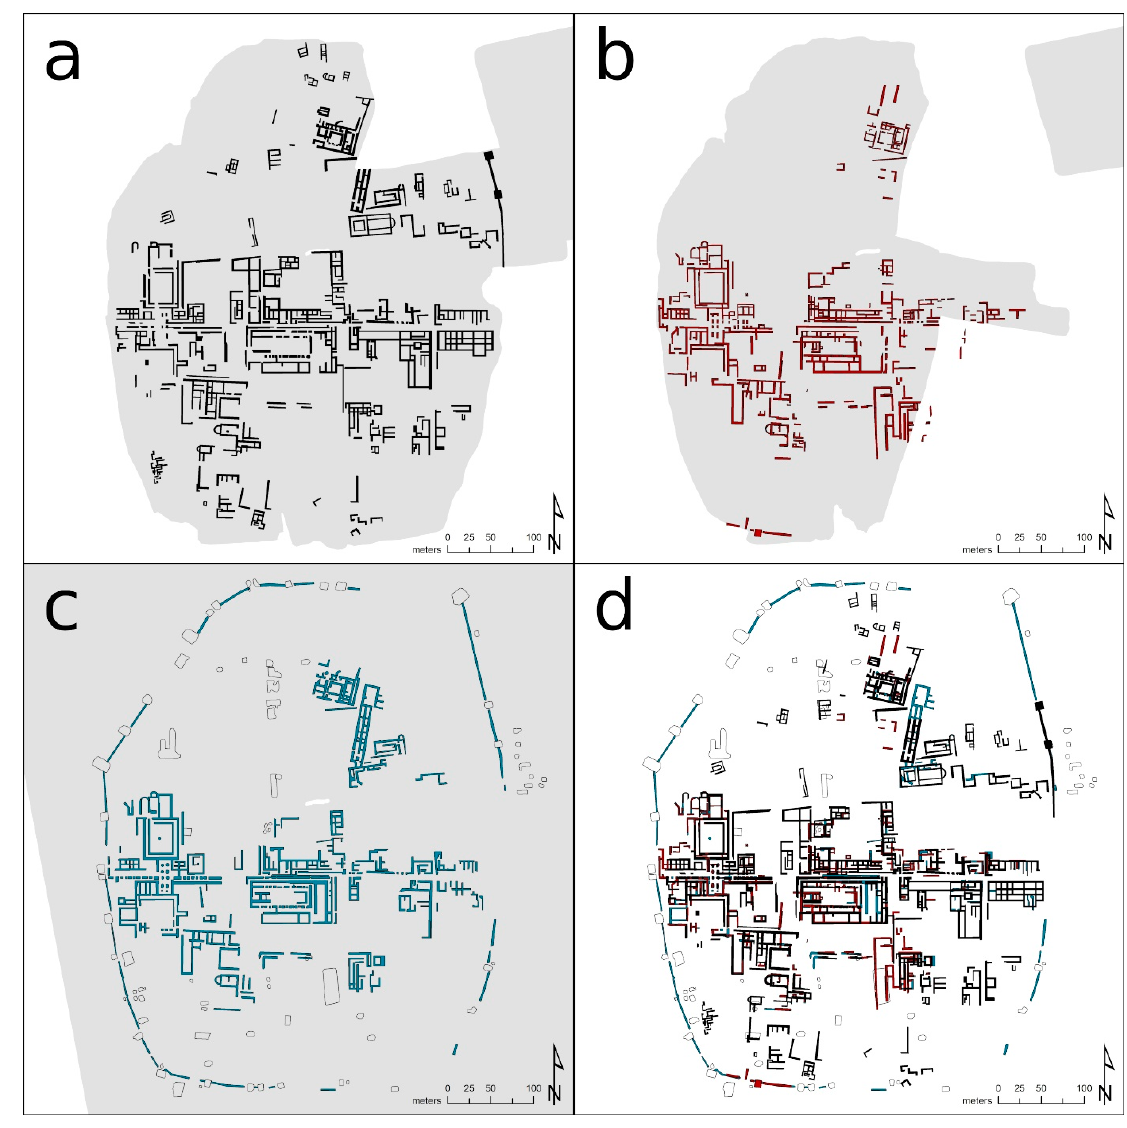
Figure 11. Comparison of the archaeological interpretations of the ( a ) magnetic, ( b ) GPR, and ( c ) topographic data sets, showing the respective coverage areas shaded in grey. ( d ) Combined information on wall structures derived from the interpretation of all three data sets.